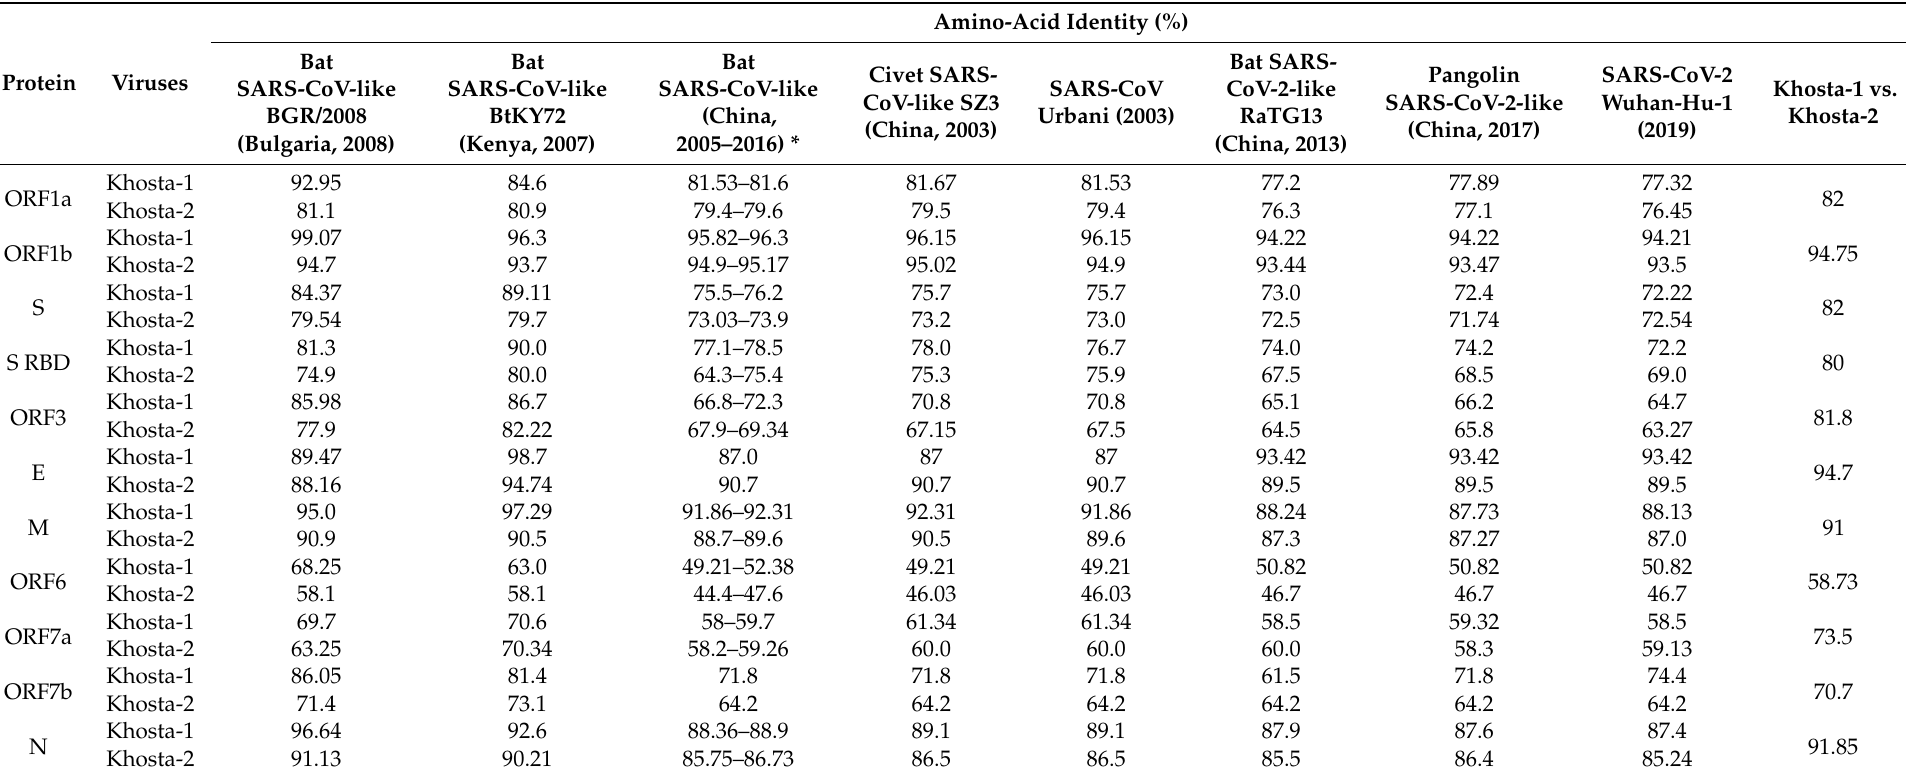
Table 2. Identity (%) of deduced amino-acid sequences of proteins of Khosta-1 and Khosta-2 viruses with certain representatives of the Sarbecovirus subgenus (lineage B of